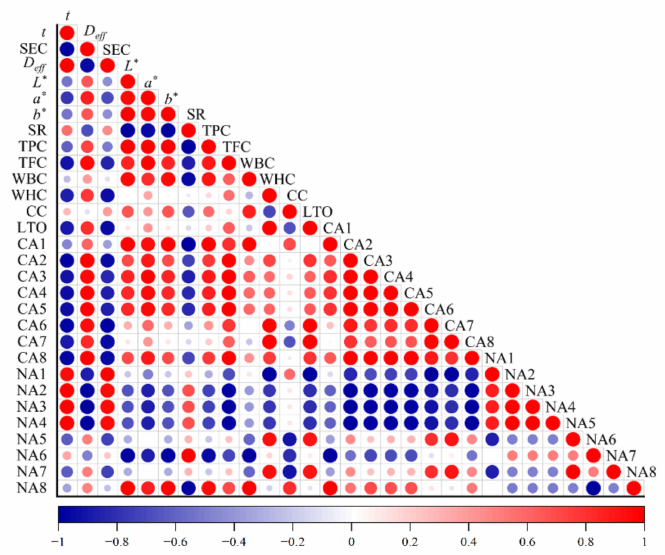
Figure 8. Pearson correlation analysis on various parameters of chrysanthemum cakes dried by different methods. t : drying time; D eff : effective moisture diffusivity; SEC : specific energy con- sumption; L *: lightness; a *: redness/greenness; b *: yellowness/blueness; SR : shrinkage ratio; TPC: total phenolic compounds: TFC: total flavonoid content; WBC : water binding capacity; WHC : water holding capacity; CC: chlorogenic acid; LTO: luteolin; CA: the content of volatile compounds; NA: the number of volatile compounds; 1: terpenes; 2: ketones; 3: esters: 4: hydrocarbons; 5: aldehydes; 6: alcohols; 7: furans; 8: phenols.